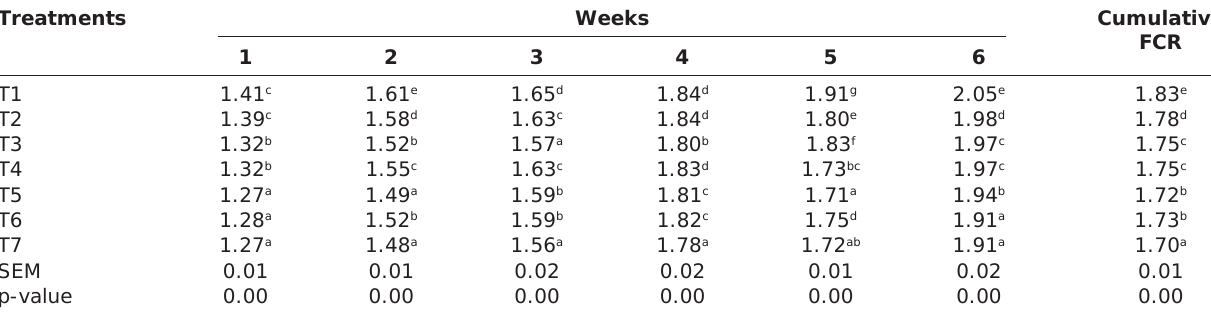
Table-2: Effect of supplementing garlic and NLPs in experimental diets on FCR of broiler chicken. Treatments Weeks Cumulative